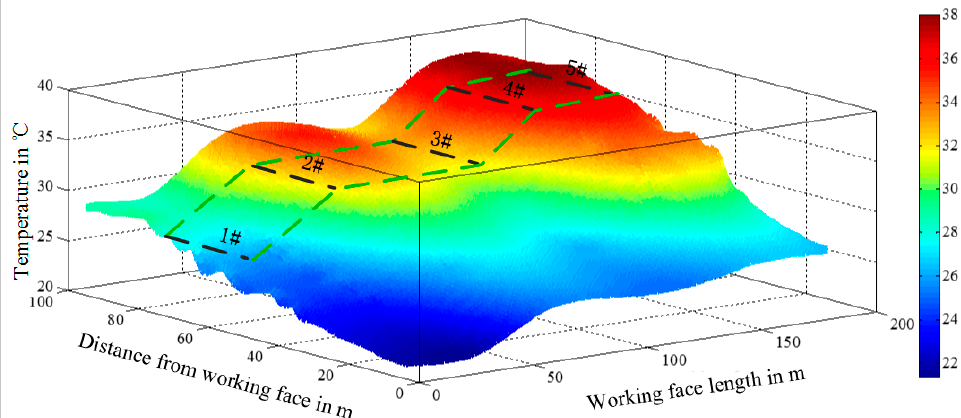
Figure 10. Cloud picture of the actual temperatures in the goaf.